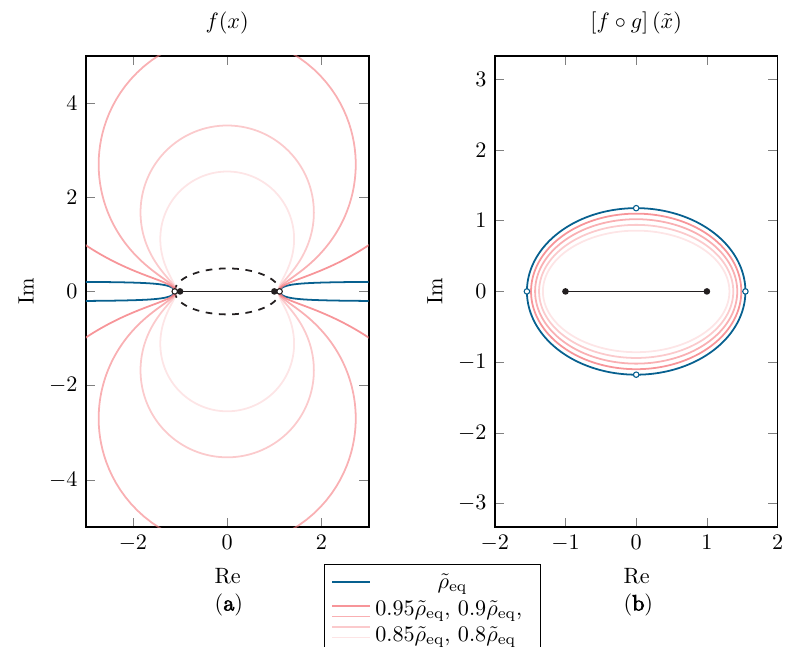
Figure 6. Starting with a Bernstein ellipse E 1.6 in the x -space, the Bernstein ellipses in the ˜ x -space with sizes ˜ ρ eq = 2.72, 0.95˜ ρ eq = 2.59, 0.9˜ ρ eq = 2.45, 0.85˜ ρ eq = 2.31 and 0.8˜ ρ eq = 2.18 are shown ( b ). The corresponding regions g ( E ˜ ρ ; κ eq ) in which analytic continuability of f is assumed are shown in ( a ). The original Bernstein ellipse E 1.6 is shown with a dashed line as a reference and the singularities are depicted with hollow dots.